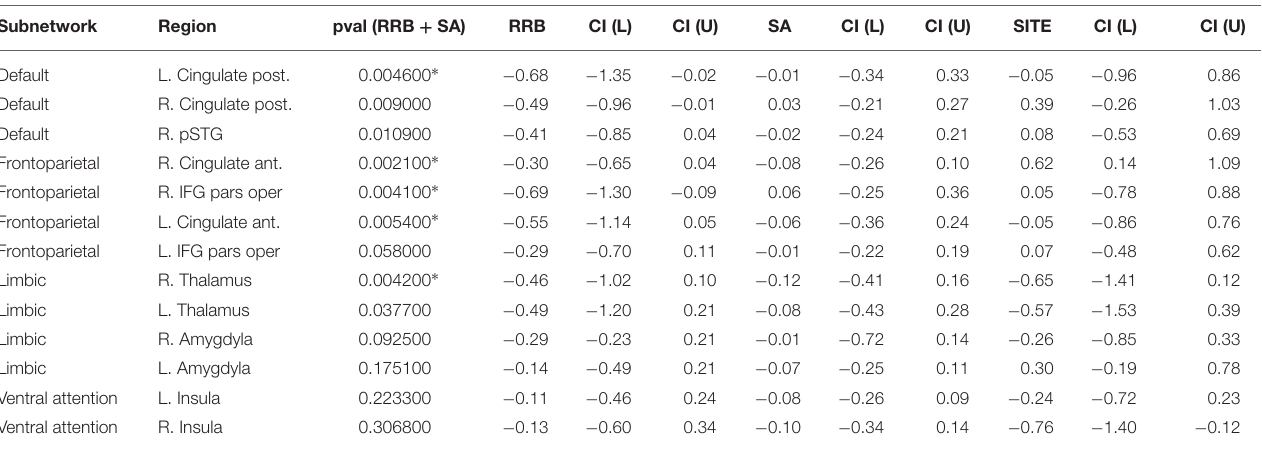
TABLE 2 | Joint ADOS covariate effects on node